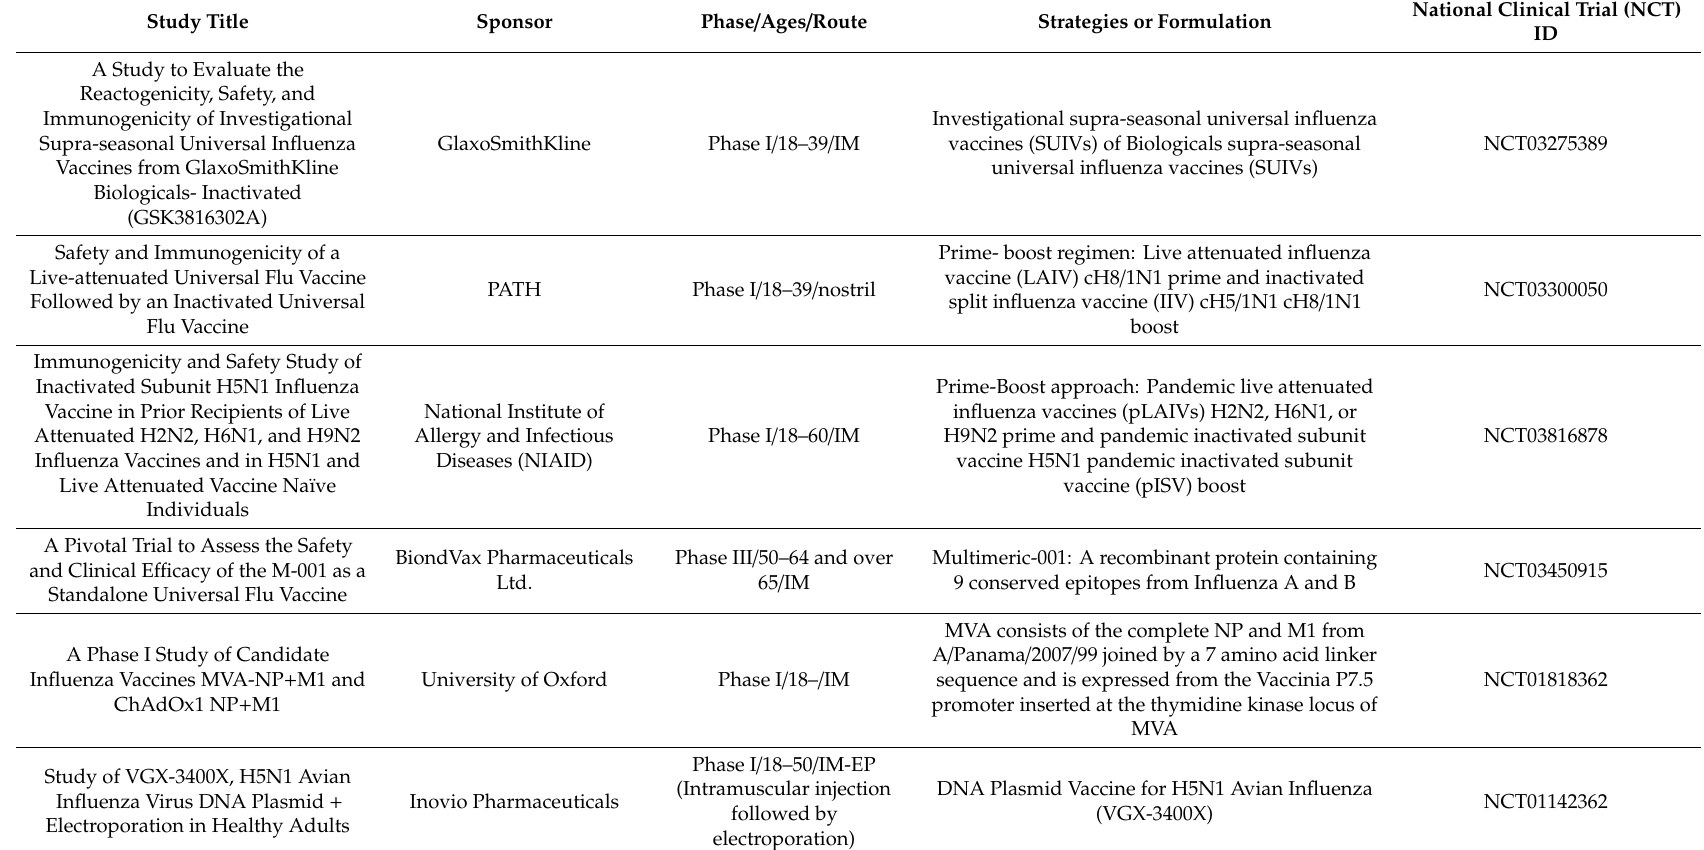
Table 1. Vaccine candidates currently being developed for the universal influenza vaccine under clinical trials. Update; 11 September